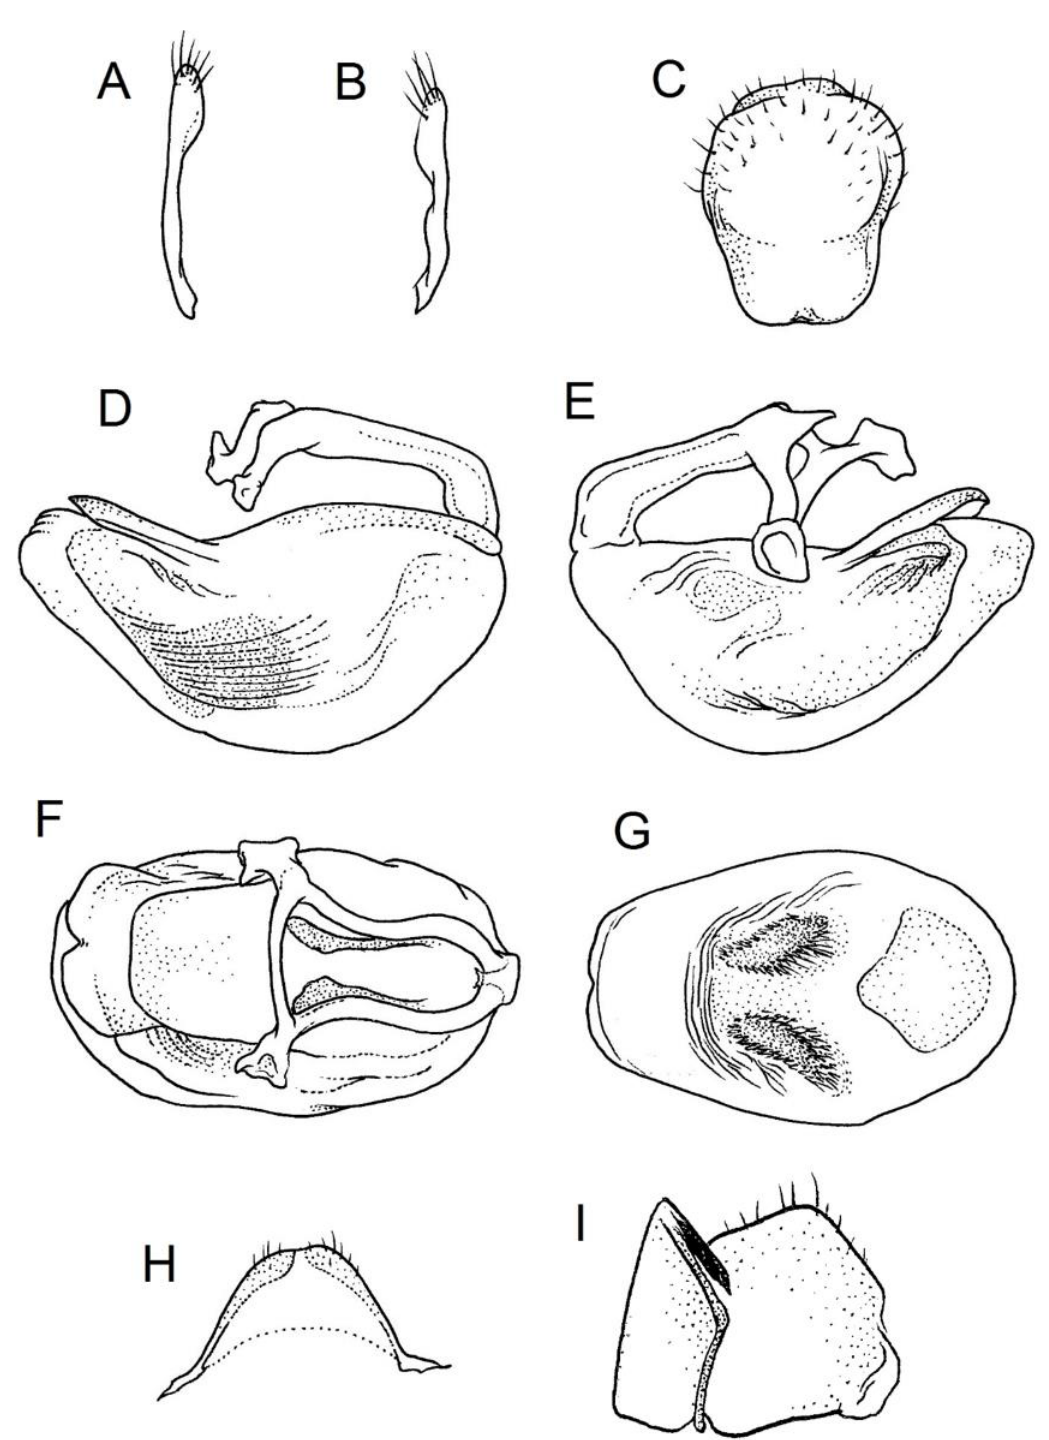
Figure 36. Phonoctonus elegans Varela, 1904: ( A ) left paramere; ( B ) right paramere; ( C ) pygophore, ventral view; ( D ) aedeagus, right lateral view; ( E ) aedeagus, left lateral view; ( F ) aedeagus, dorsal view; ( G ) aedeagus, ventral view; ( H ) styloids, outer view; and ( I ) gonocoxite of abdominal segment VIII.